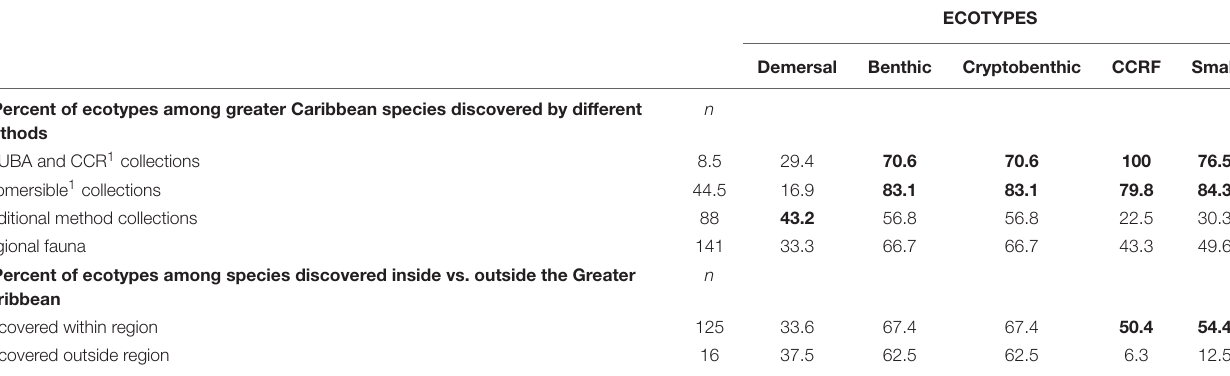
TABLE 2 | Relative abundance of different ecotypes of non-pelagic Greater Caribbean deep-reef fishes collected by different methods in and outside the Greater Caribbean